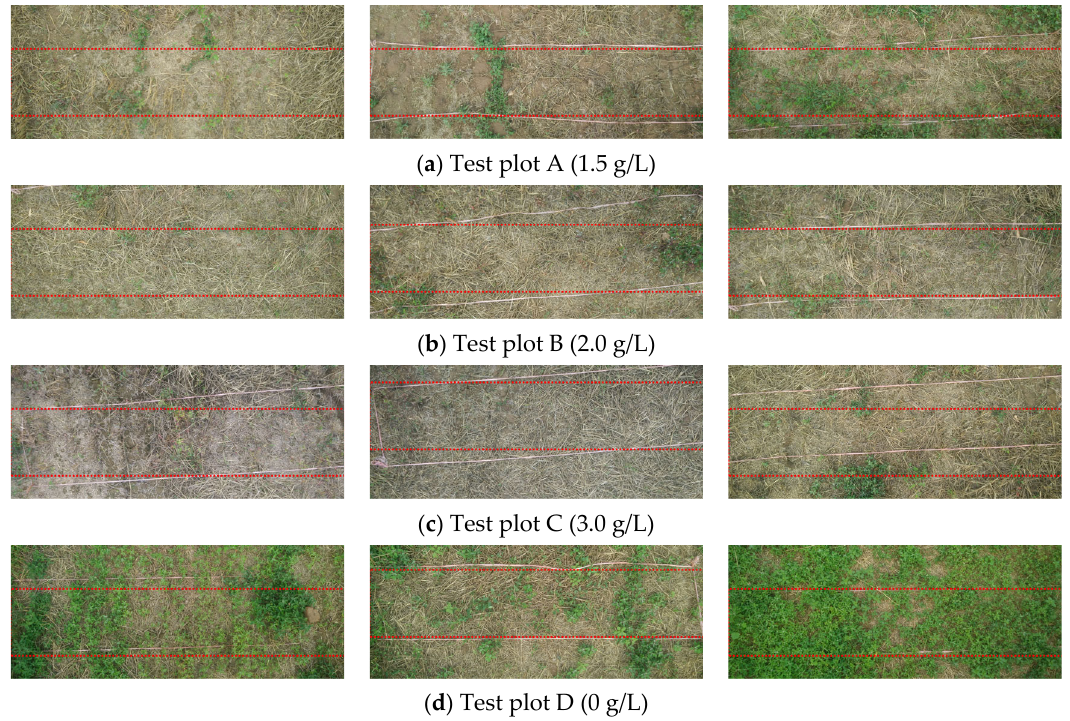
Figure 6. Weeds at the head, middle, and end of the microsprinkler hose in the test plots after 30 days of application. In each test plot, the figures from left to right represent the head, middle, and end of the microsprinkler hose. The picture shows the results of one of the three trials.